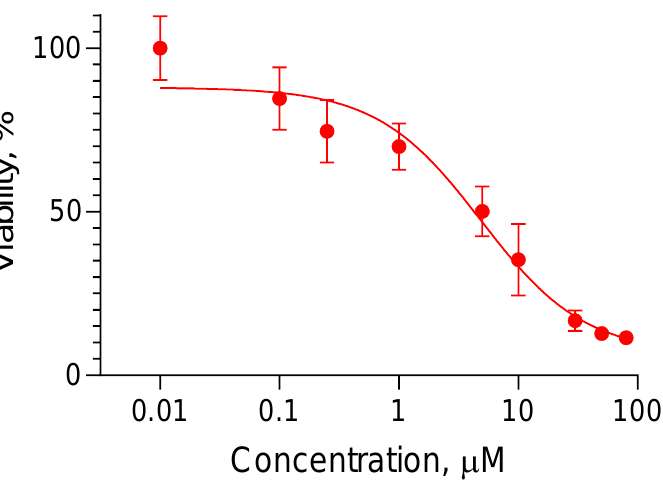
Pharmaceutics 2023 , 15 , x FOR PEER REVIEW